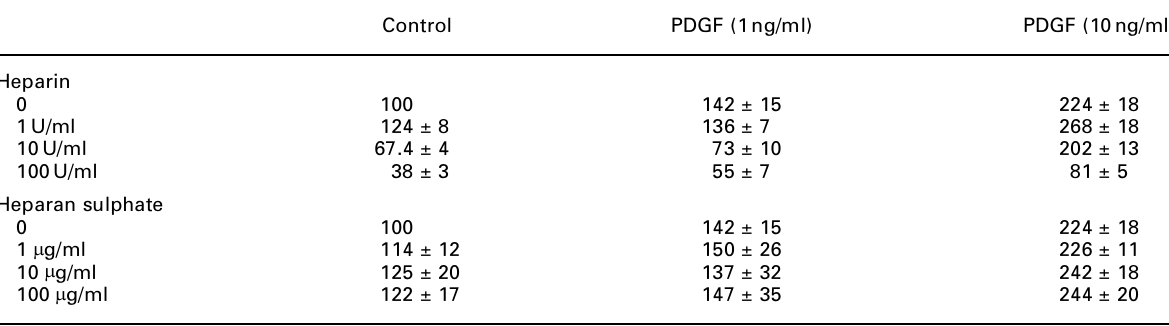
Table 1. The effects of heparin and heparan sulphate on the incorporation of [H 3 ]-thymidine by fibroblasts treated with PDGF